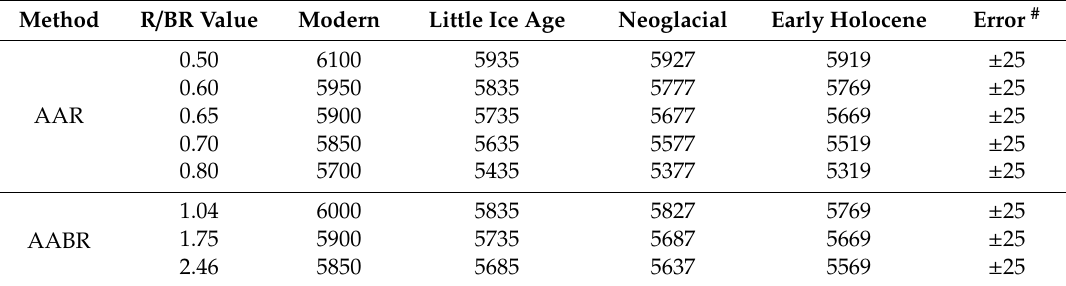
Table 2. Estimated equilibrium line altitude (ELA, in meters) using different AAR and AABR values. Method R/BR Value Modern Little Ice Age Neoglacial Early Holocene Error #